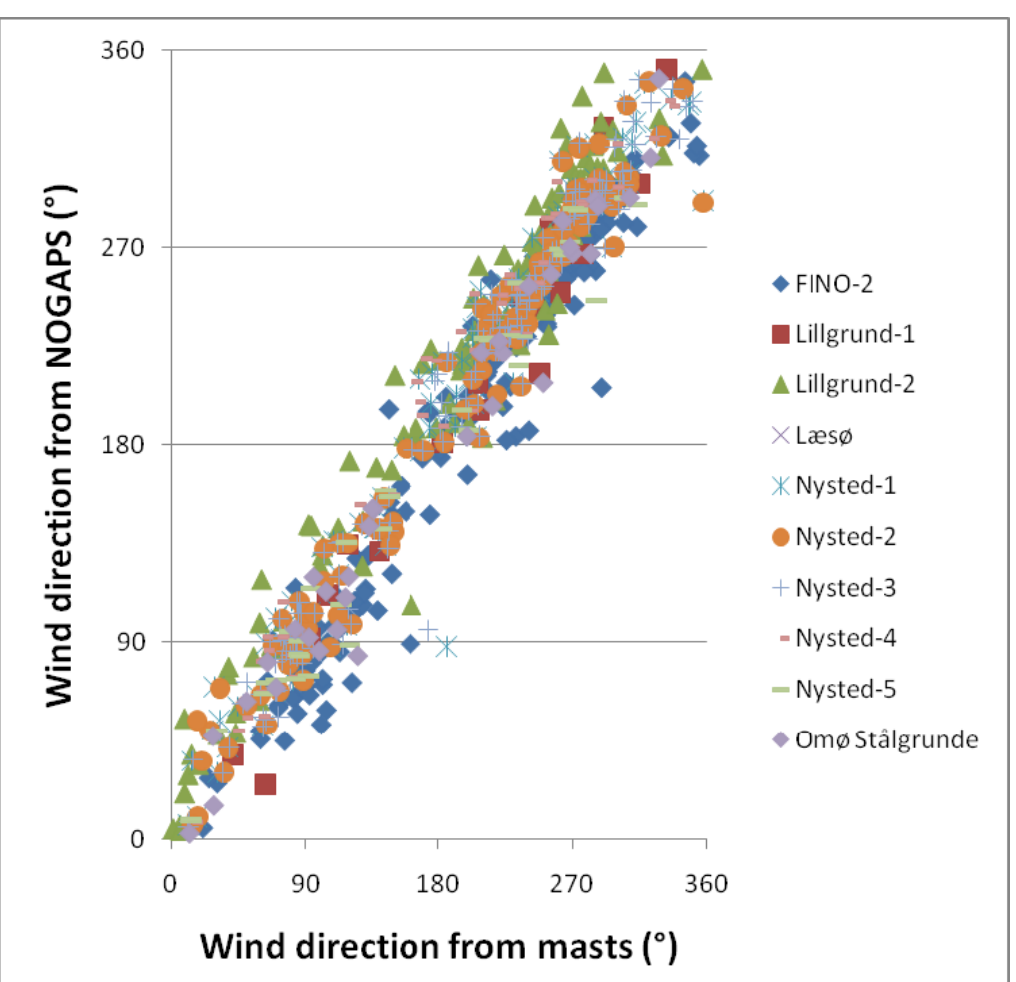
Figure 3. Wind directions from meteorological stations versus NOGAPS, N =